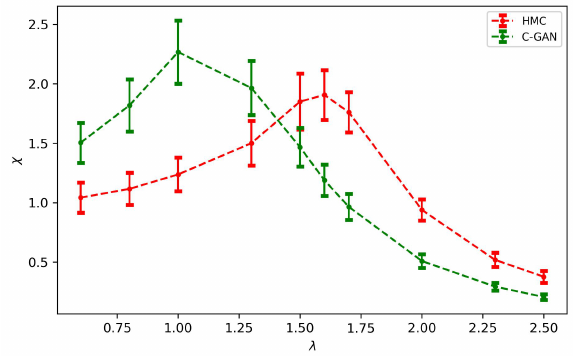
Figure 17: Ablation for log transformation: Mean 〈| ¯ σ |〉 and standard deviation on Λ set without log transformation.